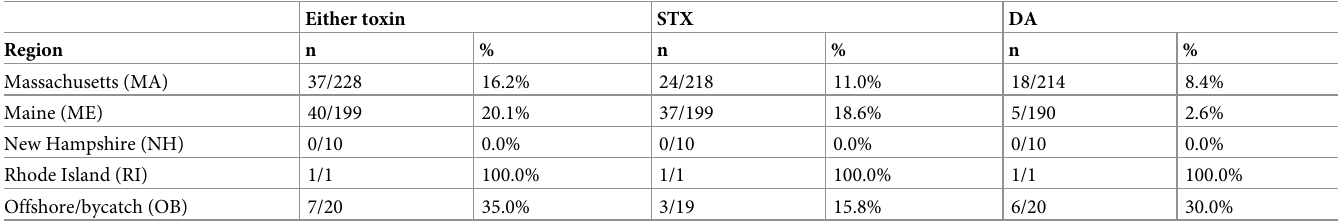
Table 3. Toxin detection frequencies by